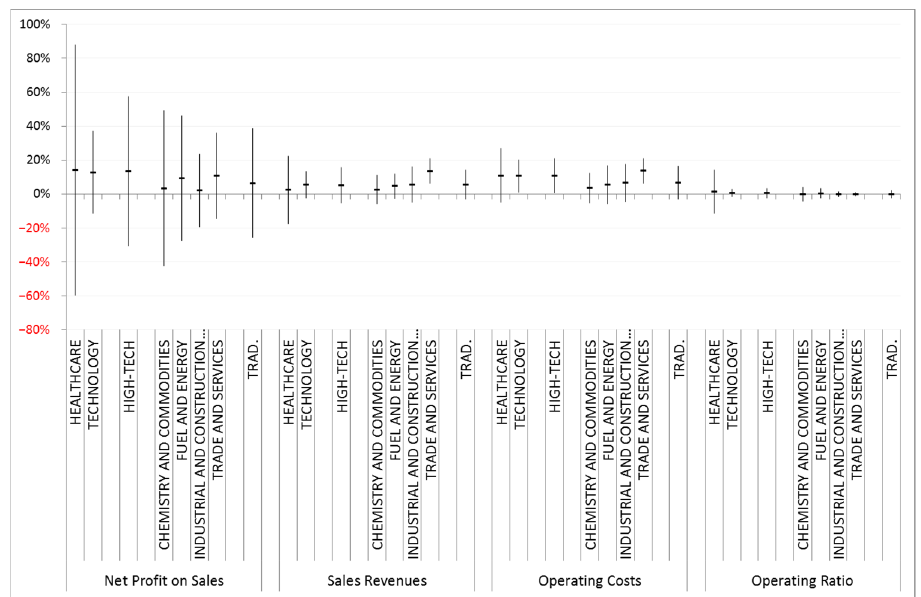
Figure 19. A typical area of variation in the area of result on sales in the analysed sectors. Source: own work.